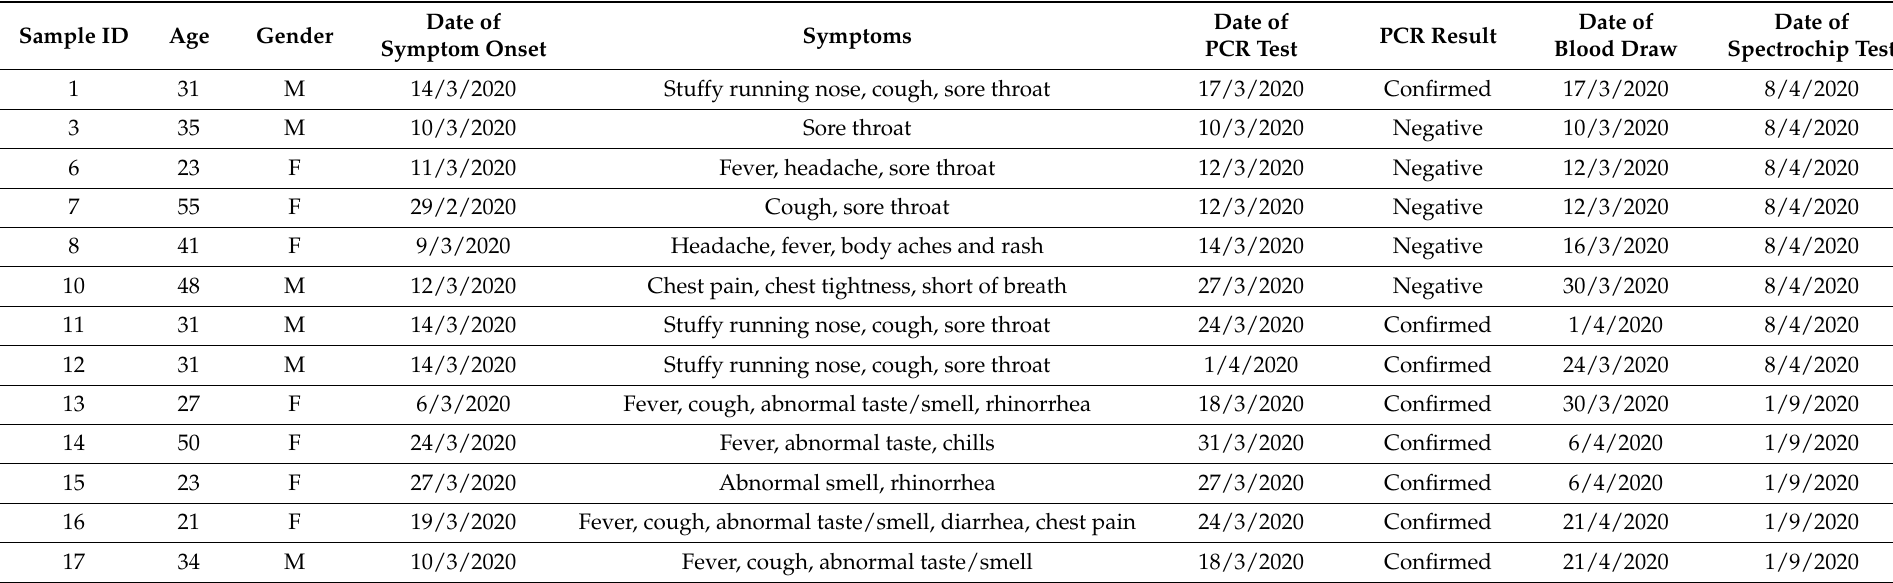
Table 2. Summary of the age, gender, symptoms, and the date of the PCR and spectrochip testing for the 13 enrolled